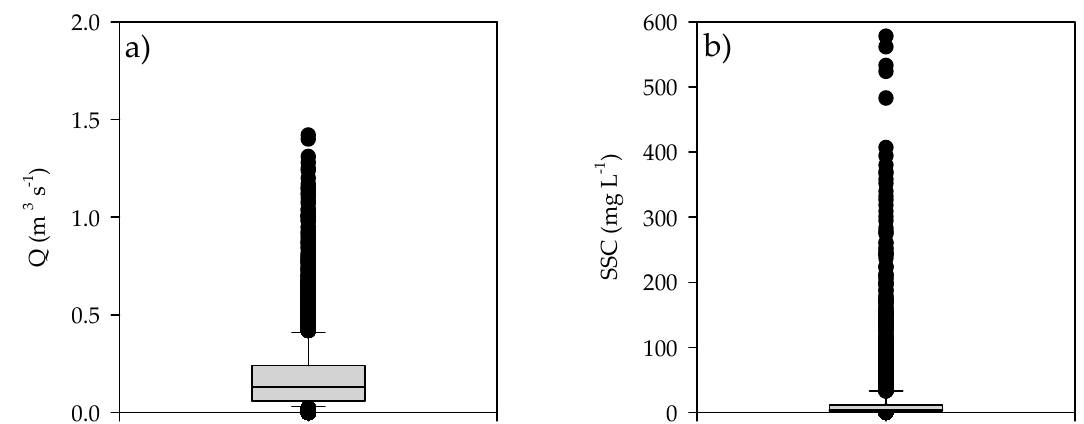
Figure 4. Box plot summarizing daily ( a ) mean discharge (Q) and ( b ) suspended sediment concentration (SSC). Each box shows the 25th, 50th and 75th percentiles. Whiskers show the 10th and 90th percentiles. Outliers outside these ranges are shown as dots.